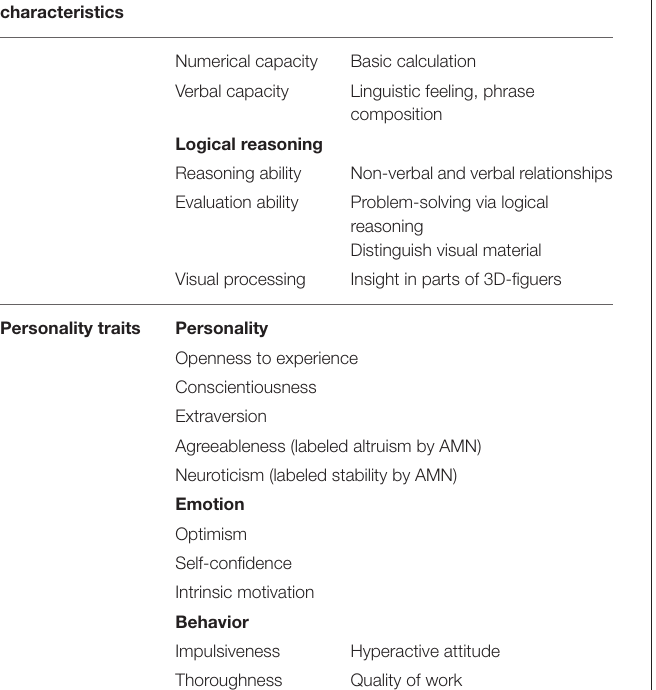
TABLE 1 | Cognitive characteristics and personality traits of AMN test. Cognitive characteristics